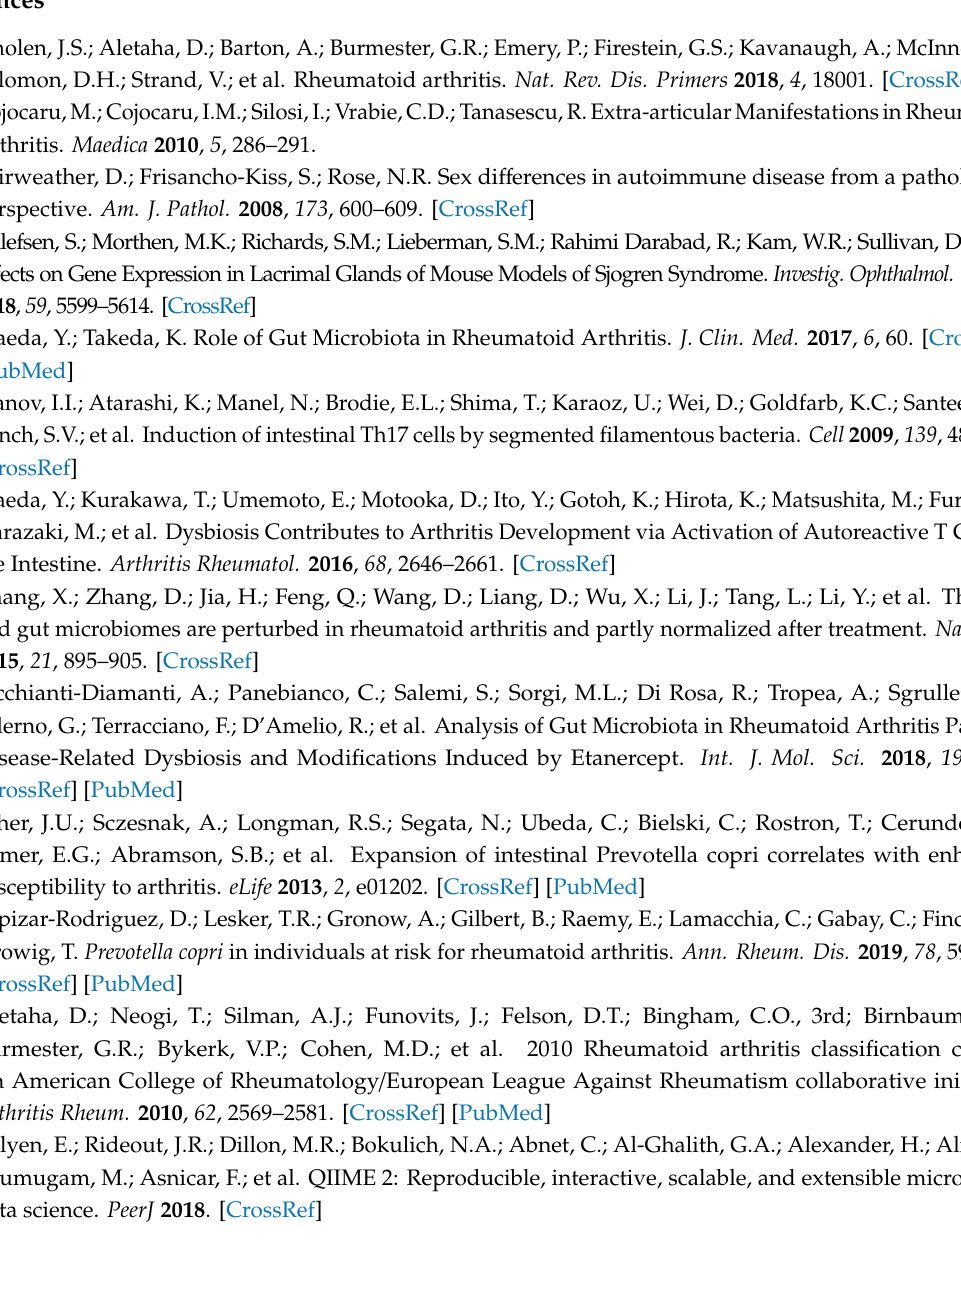
Figure S1: Comparison of alpha diversity in RA patients and healthy controls. Figure S2: The relative abundance of specific taxa. Figure S3: Microbial composition of the top 30 OTUs in CT and ER groups. Figure S4: Microbial composition of the top 30 OTUs in CT, PC, and